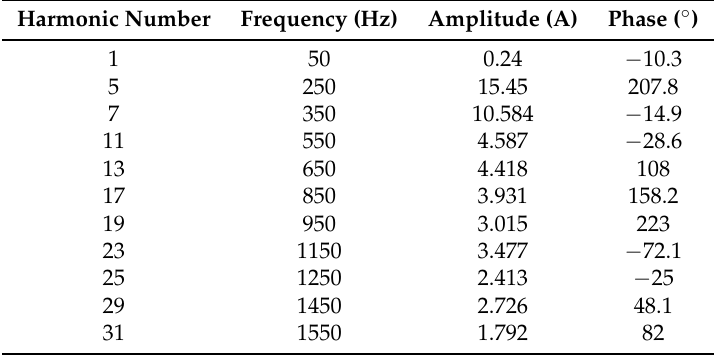
Table 5. Compensating current reference—harmonic